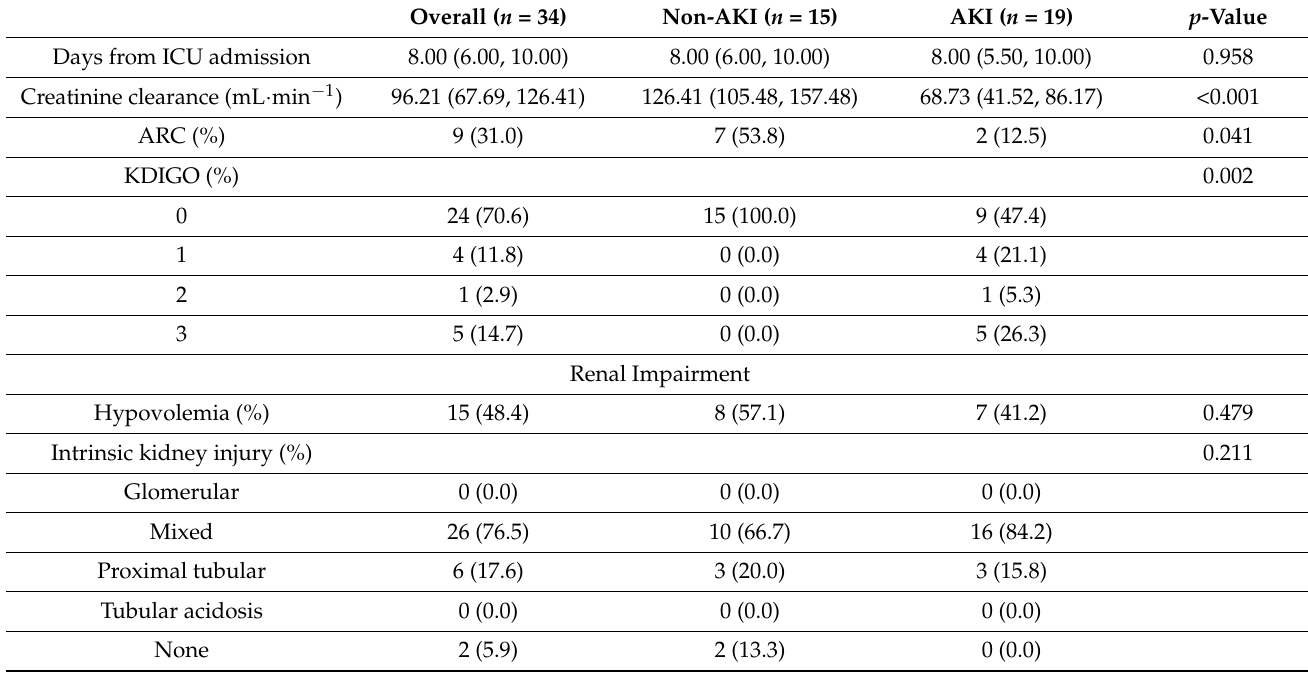
Table 2. Kidney function and impairment characterization during ICU